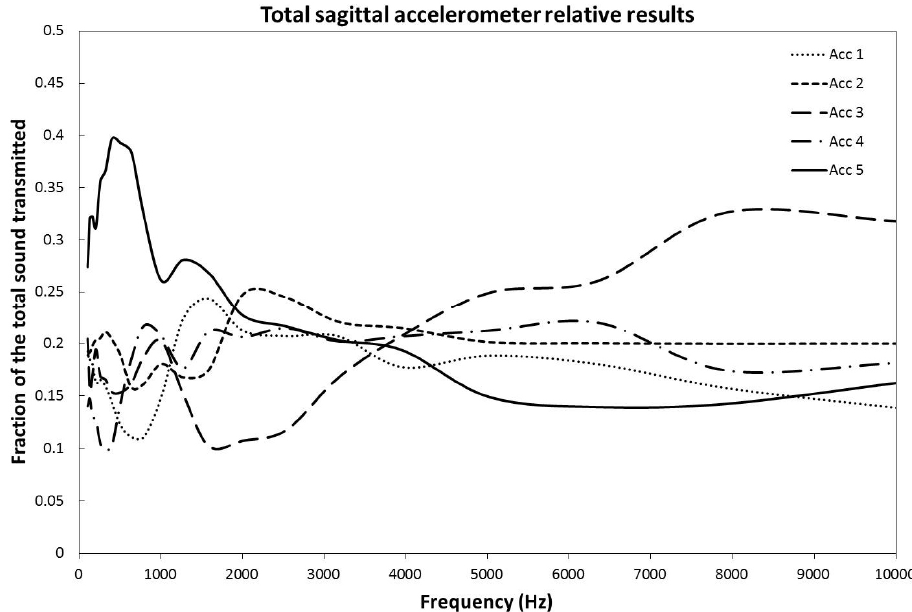
Figure 4. Relative fraction of the signal transmitted across the sagittal line by each of the five accelerometers set along it as a function of the implant signal frequency. The results have been averaged over all orientations of the BAHA TM implants about the Frankfort plane. Independent of the location of the implant, the low frequencies (100 to 1500 Hz) are preferentially transmitted via the most frontally located accelerometer (#5). With a zero degree placed BAHA™ implant, the frontal accelerometer recorded a peak of 36% of all the transmission at 1272 Hz, 47% of all transmission at 396.5 Hz for a 45 degrees’ placement and 42% at 502 Hz for a 90 degrees’ placement. The average overall peak was 40% of the signal at 396.5 Hz. In the mid-range frequencies, from 1500 to 5000 Hz, no dominance of transmission can be clearly established. In the uppermost frequencies analyzed, a dominance of transmission is observed from accelerator #3 situated on the superior part of the